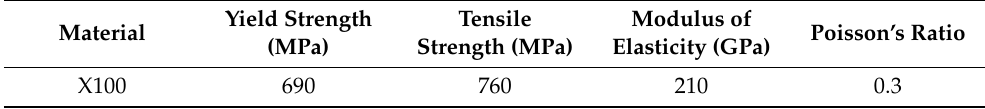
Table 1. Parameters of the pipe section